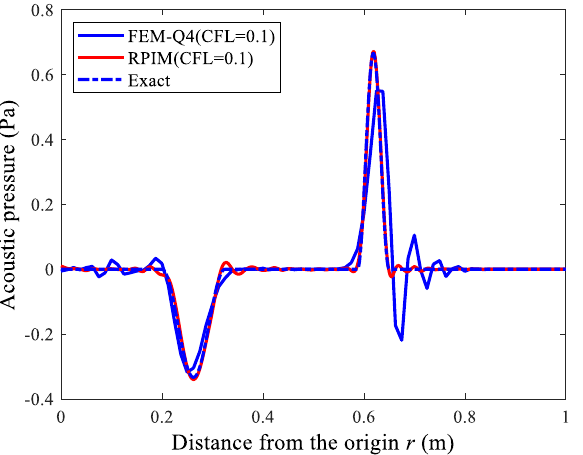
Figure 8. The computed numerical solutions of the acoustic pressure distributions for the two-di- mensional tube from different numerical approaches when the time point t = 0.8 s.